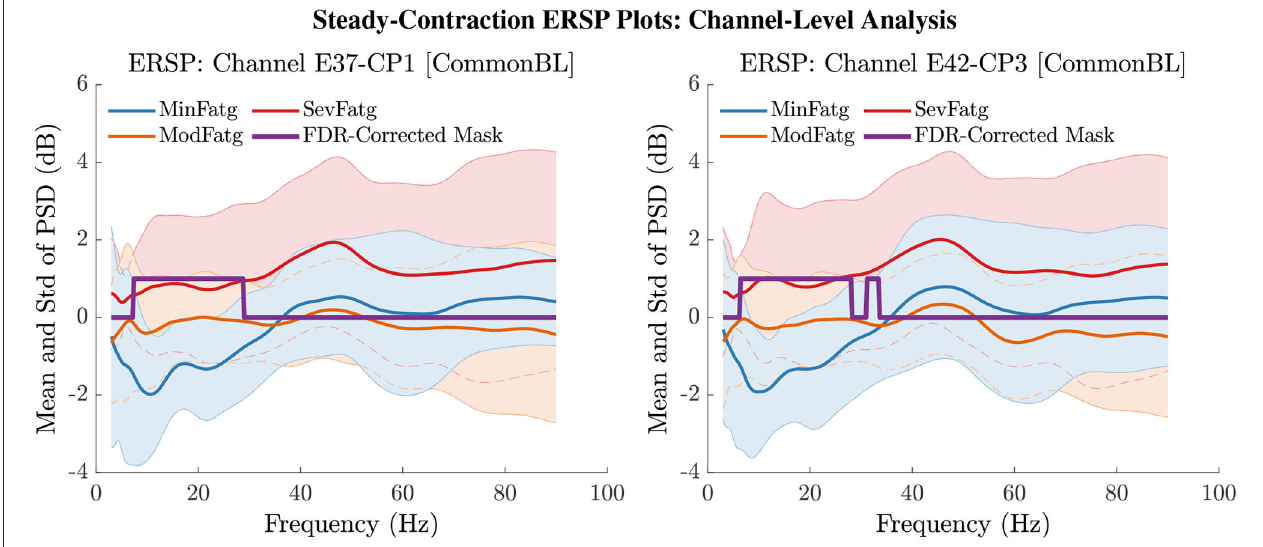
FIGURE 6 | The ERSP values at time-frequency points were averaged over the steady-contraction period of 1s to 3s for EEG signals. The plots produced from FatgCond ∼ ERSP help understand how the time-averaged PSD computed for the scalp EEG varies with IMT-induced fatigue. The mean and standard deviation (std) of PSD pertaining to the three fatigue conditions are expressed as functions of frequency within the range 3Hz to 90Hz for the EEG channel CP1 (left panel) and CP3 (right panel). The frequencies at which the PSD differs across the fatigue conditions with a statistical significance ( p < 0.05) are assigned a value one and the rest of the frequencies a value zero by the FDR-corrected mask.